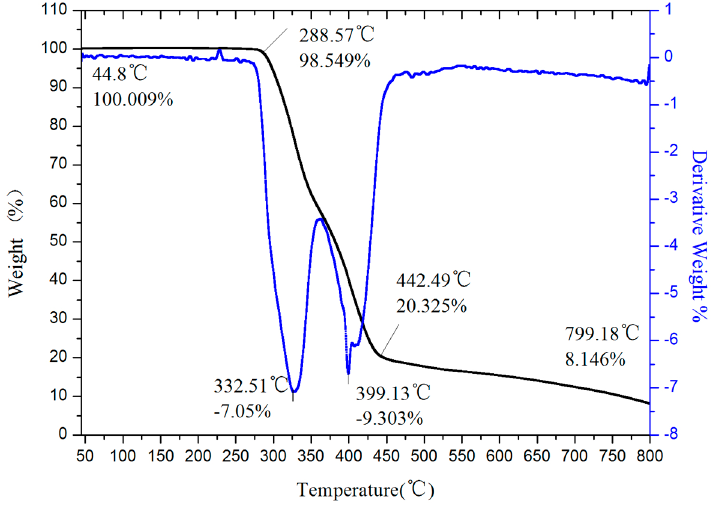
Figure 10. Thermal studies of the fluorescence chemosensor.